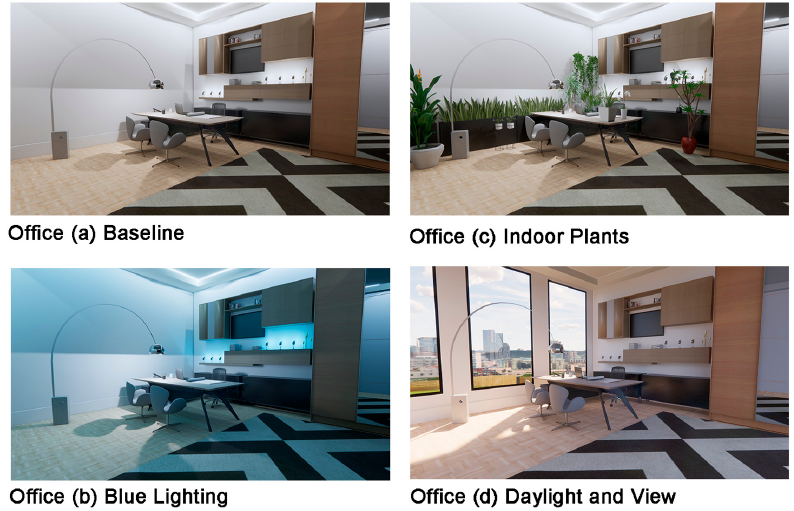
Figure 1. The four rendered scenes of an office with different design interventions.